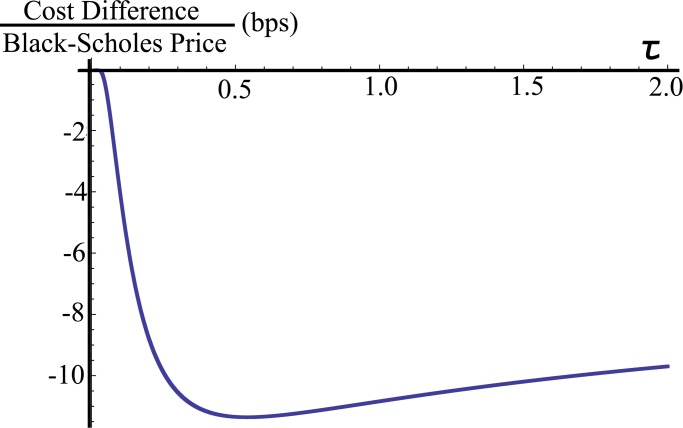
Option price difference for different maturities.Difference in option prices (proposed vs. Black-Scholes) expressed as a percent of the Black-Scholes price for different times to maturity τ, where K = 21 USD, σ = 0.265 years−1/2, γ = 0.068 years−1/3 and r = 0.035 years−1.